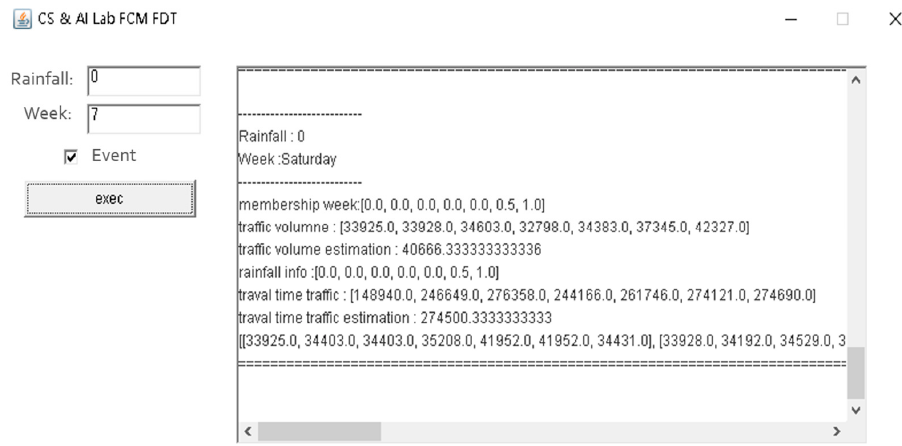
Figure 6. Example of an FCM simulator.